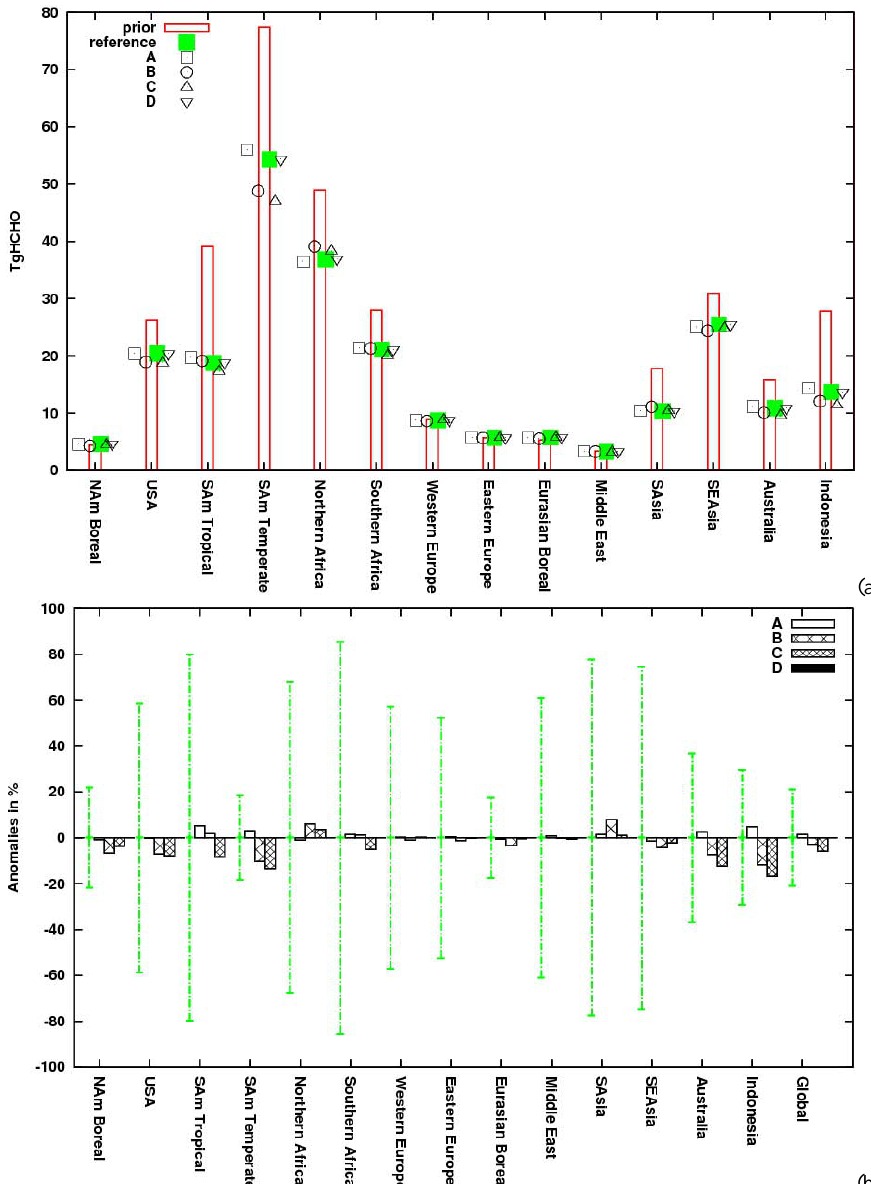
Fig. 10. (a) Regional 3-D HCHO production by NMVOC calculated for year 2006. The red bar represents the prior production and each symbol a posterior production, for the reference inversion (in green) and the four sensitivity cases (in black). Case A: OH-v2 field; Case B: error on the HCHO 3-D production set to 200%; Case C: error on the prior CO emissions set to 150%; Case D: error on the prior MCF emissions set to 10%. (b) Differences of the posterior HCHO production between the sensitivity tests and the reference inversion (in % relative to the reference). Error bars show the 1- σ uncertainty associated with the posterior reference (calculated using the Monte-Carlo approach, see Sect. 4 for